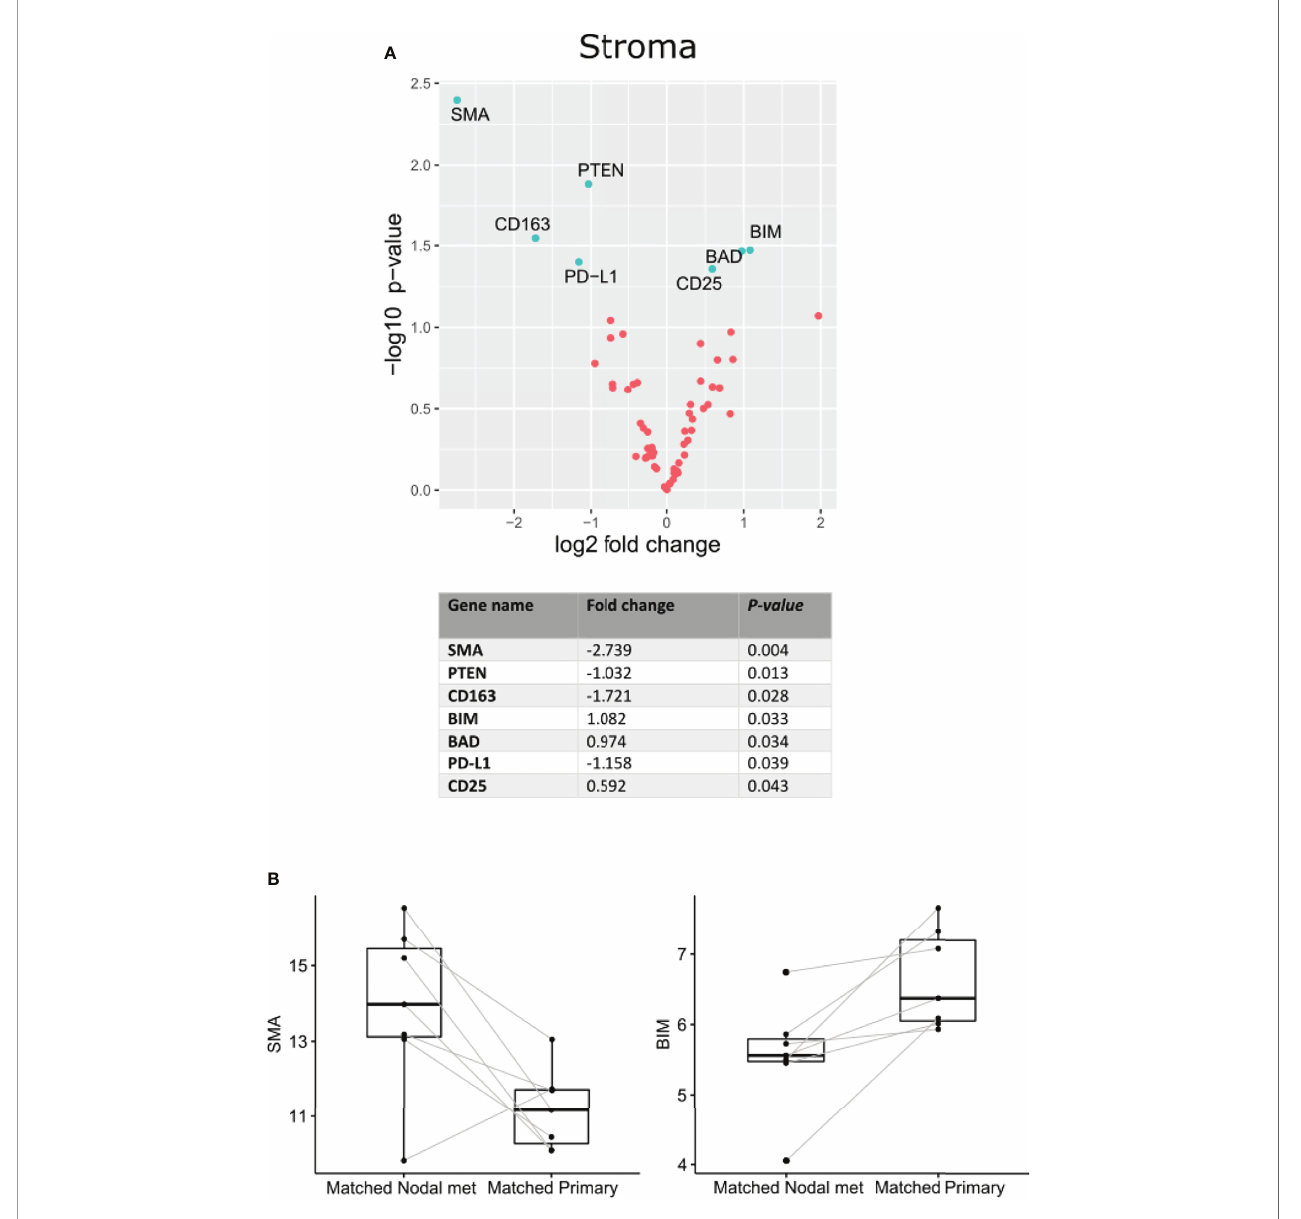
FIGURE 3 | Differential protein expression comparing specimens from matched OPSCC primary tumors and nodal metastasis (n = 7). (A) Upper panel. Volcano scatter plot showing stromal enrichment of proteins from nodal metastases (left) vs primary tumors (right) ranked by signi fi cance ( − log10 P -value). Lower panel. List of top seven signi fi cant deregulated proteins ranked by P -value. (B) Representative boxplots indicating SMA and BIM enrichment in matched nodal metastasis and matched primary specimens,